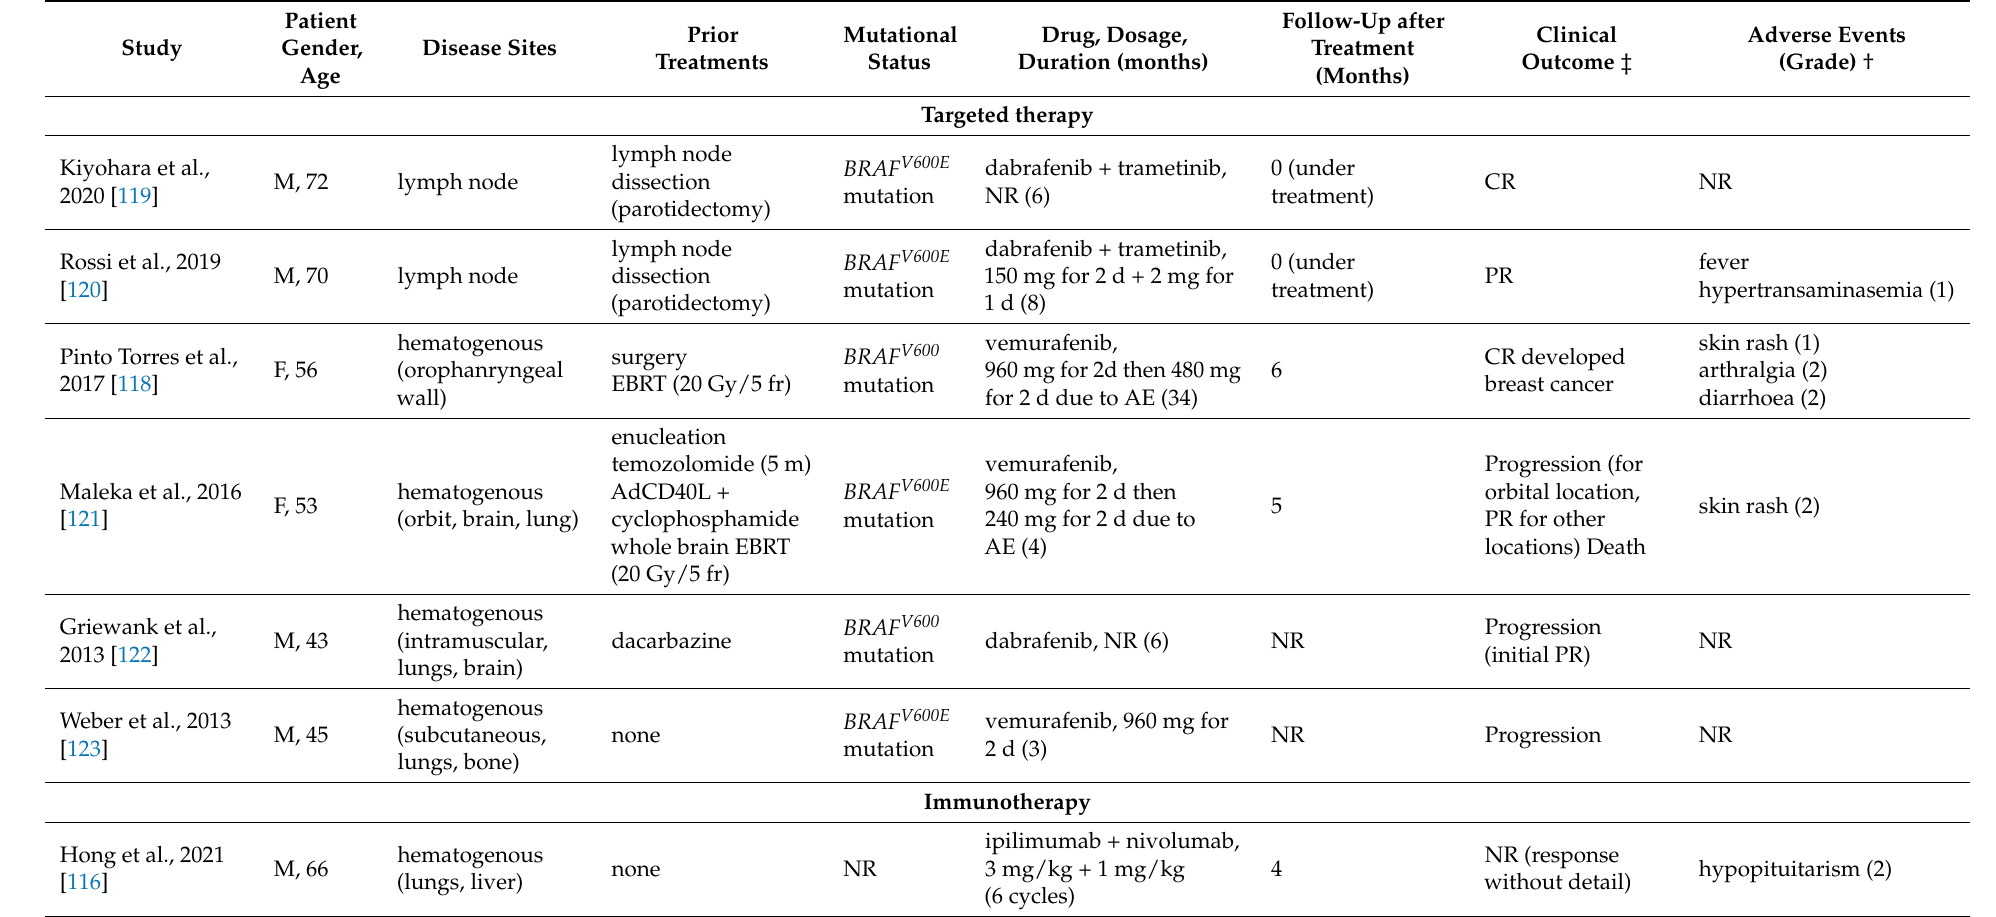
Table 2. Previous reports of treatment in patients with metastatic